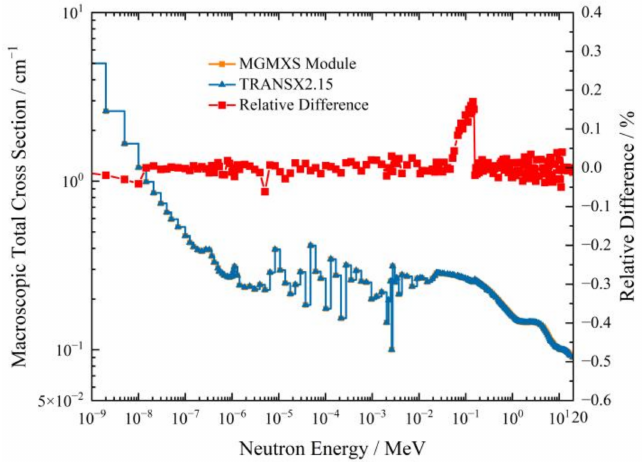
Figure 3. The relative differences of macroscopic total cross-sections.